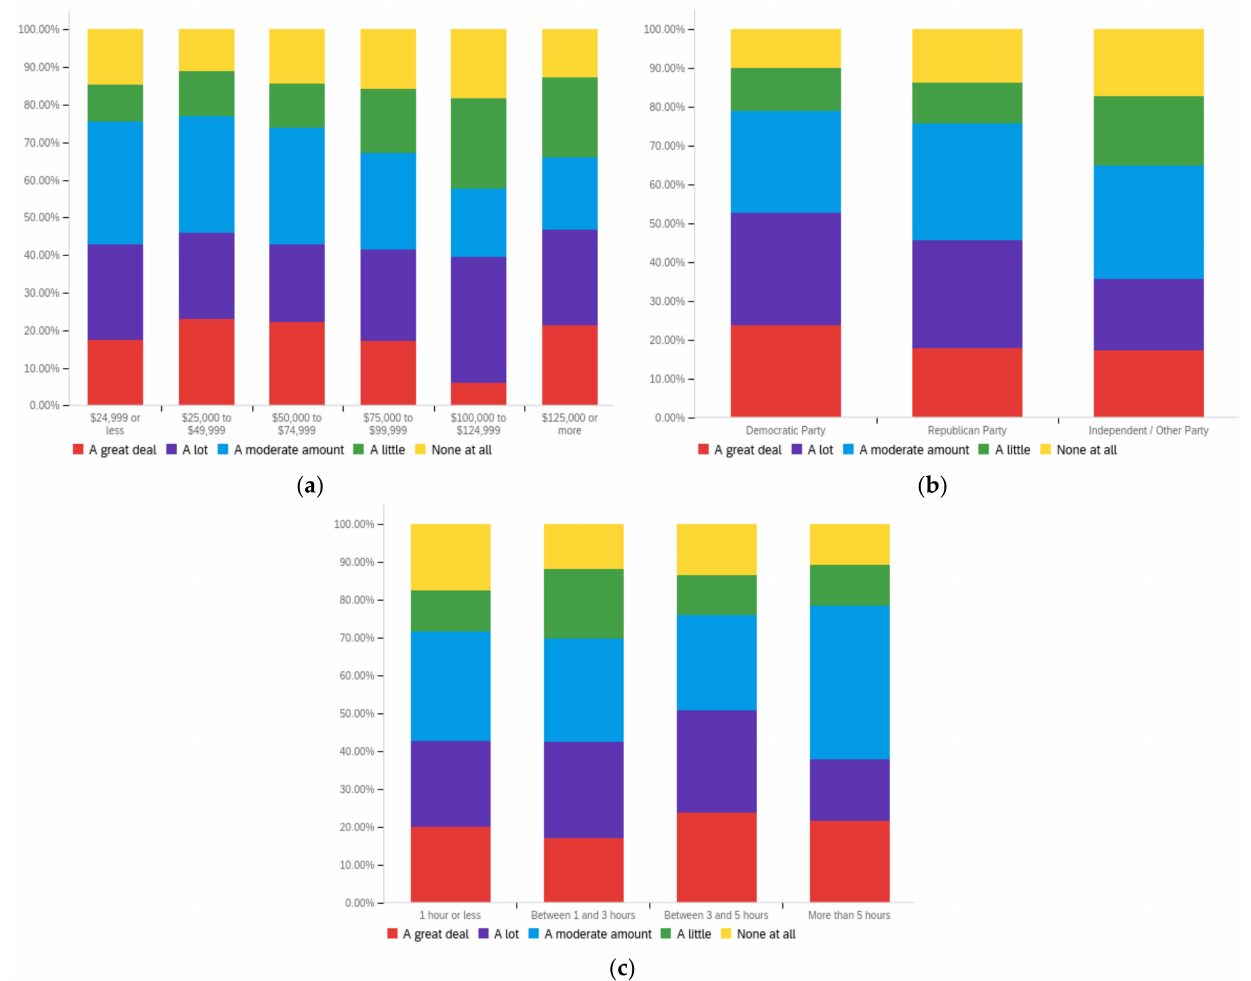
Figure A34. Article reading level—personal perception impact by: ( a ) income level (top left), ( b ) po- litical affiliation (top right) and ( c ) online usage (bottom).